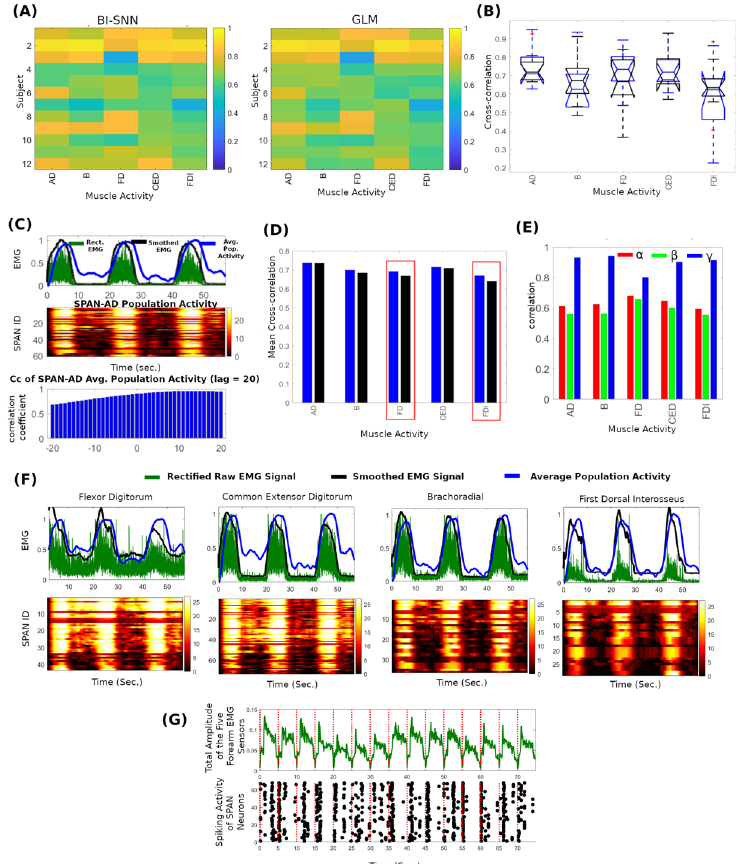
Figure 2. Comparative analysis of decoding muscle activity from EEG using BI-SNN and GLM approaches. ( A ) Normalised cross-correlation coefficients between the actual and predicted muscle activity from anterior deltoid (AD), brachoradial (B), flexor digitorum (FD), common extensor digitorum (CED) and first dorsal interosseous (FDI) muscles by BI-SNN and GLM methods. ( B ) Statistical distribution of the correlation coefficients by BI-SNN (blue) and GLM (black). ( C ) Calculation of the normalised cross-correlation coefficients between EMG activity of AD muscle and SPAN AD population activity. Top: rectified (green) and smoothed (black) EMG signal from the AD muscle of participant 2, and the average convoluted spike sequence generated by the SPAN AD (blue) population (The alpha kernel was used for spike convolution—refer Eq. (8)), middle: convoluted spike sequences emitted by spiking neurons in SPAN AD population, bottom: normalised cross-correlation coefficients between the smoothed rectified EMG signal and the average SPAN AD convoluted population activity using cross-correlation lag of 200 ms. ( D ) Comparison of the mean cross-correlation coefficients by the BI-SNN and GLM approaches (statistically significant differences are highlighted in red). ( E ) Band-specific cross-correlation coefficients of participant 2. ( F ) Actual muscle activity of B, FD, CED, FDI muscles and the response of corresponding SPAN population (SPAN B , SPAN FD , SPAN CED , SPAN FDI ). ( G ) Population activity of SPAN movement-onset and the accumulated amplitude of the five EMG